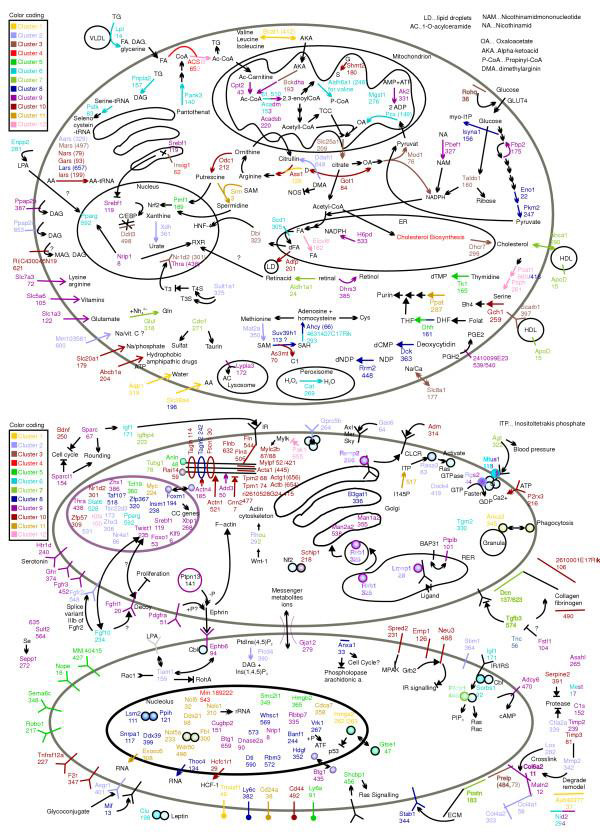
Cellular localization of gene products. Shown are the cellular localizations of gene products involved in (a) metabolism and (b) other biological processes during fat cell differentiation. Gene products are color coded for each of the 12 clusters (key given to the left of the figure). The numbering is given according to the de novo functional annotation (Additional data files 6, 7, 8).